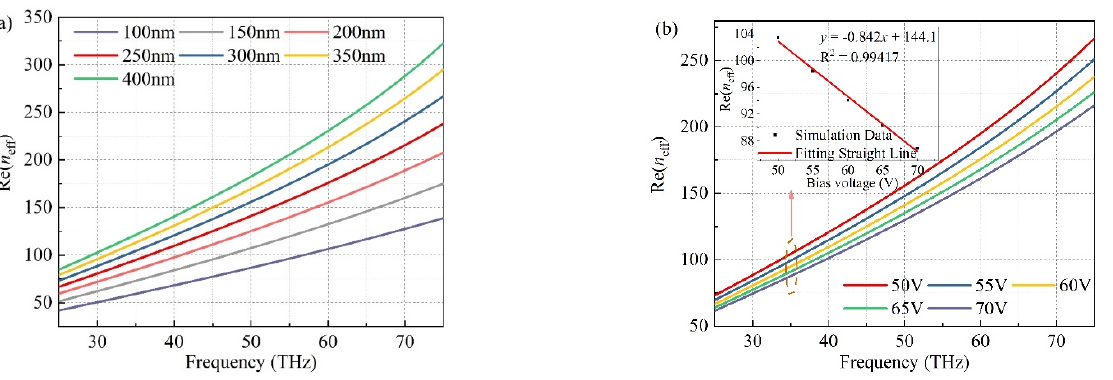
Figure 2. Effective refractive index of TM mode at air-graphene-silica structure for different silica layer thicknesses h with the bias voltage of 60 V ( a ) and for different gate voltages V b with the silica thickness of 250 nm ( b ). The insets shows that the linear relationship between the effective refractive index and bias voltage at 35 THz.